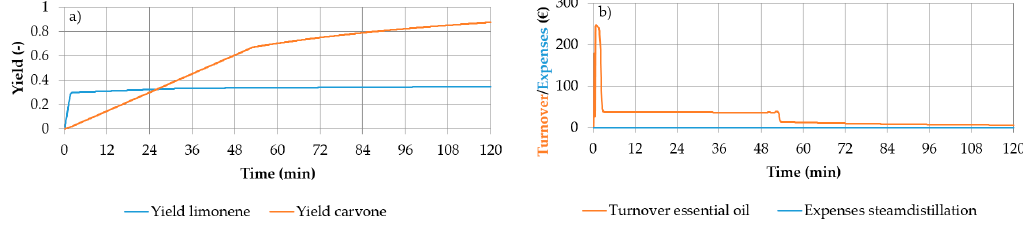
Figure 20. Yield ( a ) and cost ( b ) calculation of Figure 20. Yield (a) and cost (b) calculation of caraway.